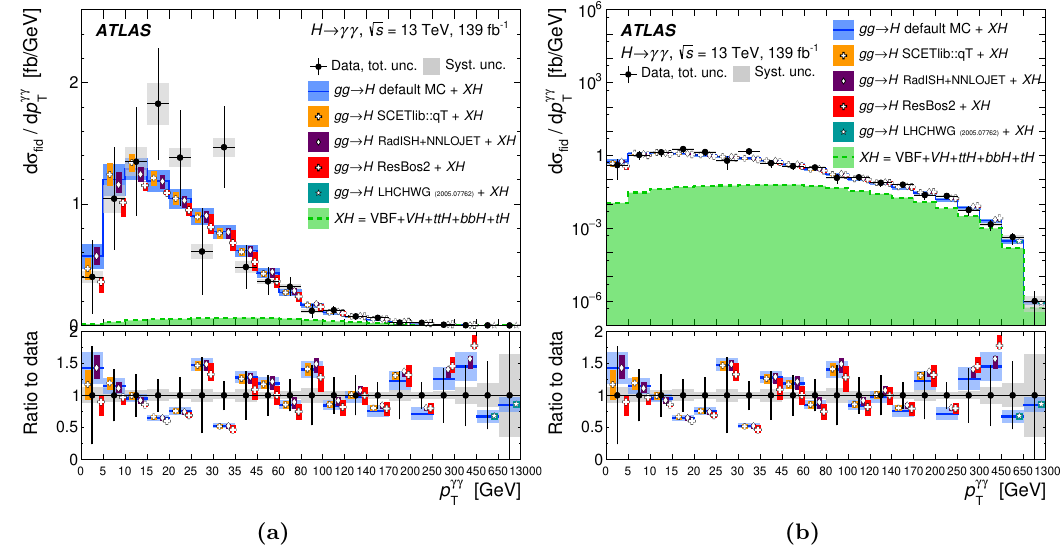
Figure 8. Particle-level fiducial differential cross-sections times branching ratio for the diphoton variable p γγ in (a) linear and (b) logarithmic scale. The measured cross-sections are compared with T several predictions changing the ggF components as described in the text: the default simulation, SCETlib ::qT (up to 200 GeV), RadISH+NNLOjet (up to 450 GeV), ResBos2 (up to 450 GeV) and LHCHWG (for the two highest p bins). Total uncertainties are indicated by the error bars on T the data points, while the systematic uncertainties are indicated by the boxes. The uncertainties in the predictions are indicated with shaded bands. The bottom panel shows the predicted values from the top panel divided by